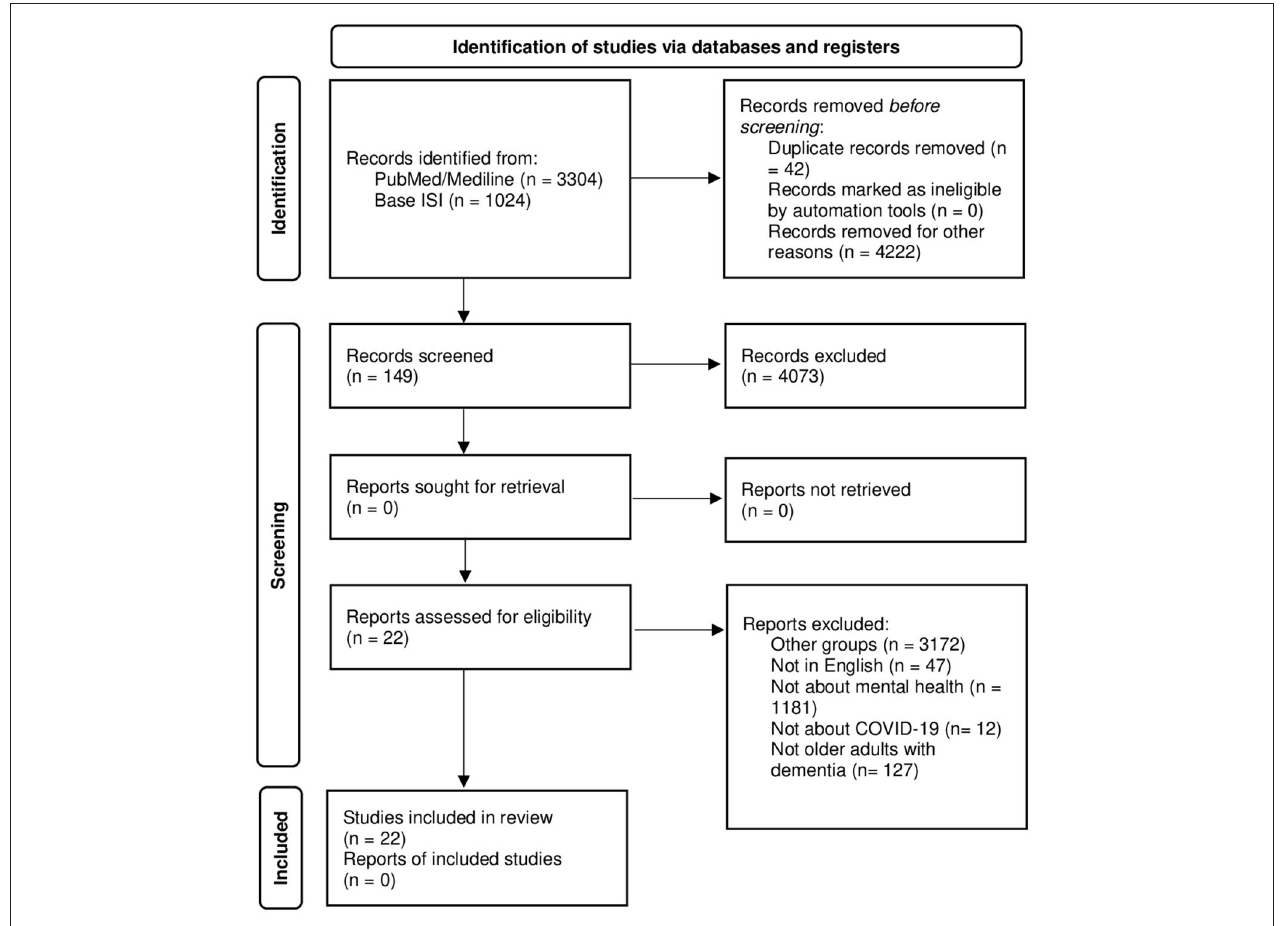
FIGURE 1 | Flow chart describing data